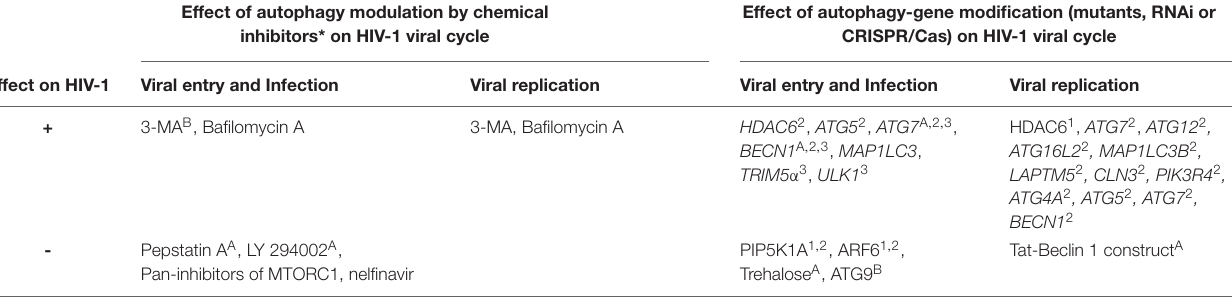
The table summarizes the autophagy modulatory effect on HIV-1 viral cycle (viral entry and infection or viral replication) exerted either by chemical inhibitors acting on autophagy-associated factors, *which could activate or prevent autophagy, or by acting on autophagy-associated genes by using related mutants, specific RNA interference or CRISPR/Cas editing, as follows: 1 Dead mutant or modified protein; 2 RNAi; 3 CRISPR/Cas9. Left column groups the reported positive ( +) and negative ( − ) effects on the viral cycle. In general, all these data refer to results obtained in CD4 + T lymphocytes, and when data have also been reported in other cell types and tissues, they are indicated as follows: A Macrophages, B DCs and C studies in CNS (microglia). This information is illustrated in Figure 2